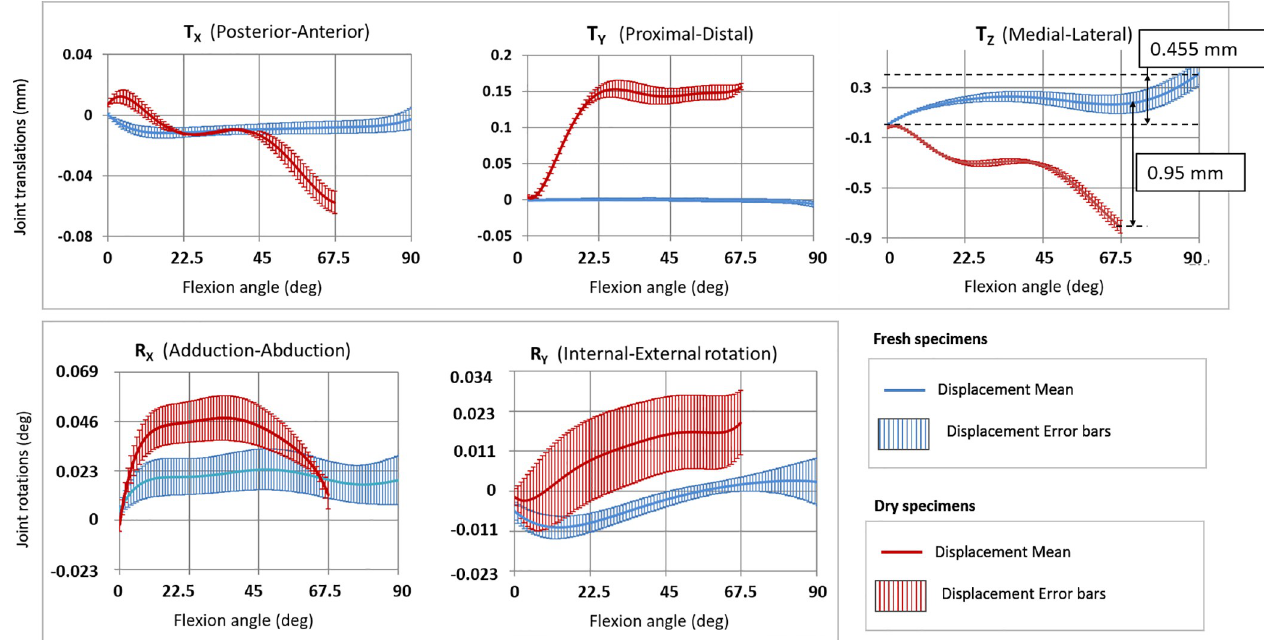
Fig 7. Decomposed elbow displacements. Mean and error bar of the 5 displacements as function of the flexion angle for fresh specimens with ligaments and dry bone specimens. flexion axis) are represented. The results coming from model 3 (revolute joint combined with a medial-lateral translation) are plotted in blue sky.